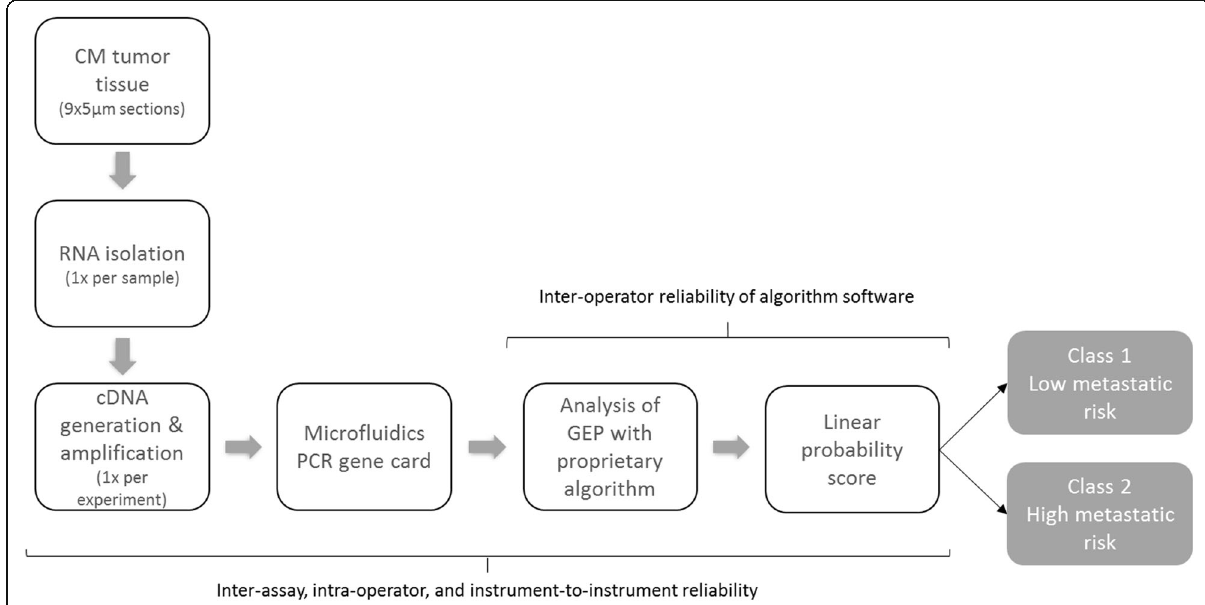
Fig. 1 Workflow schematic of the DecisionDx-Melanoma test. Steps in the performance of the test are presented along with the corresponding reliability